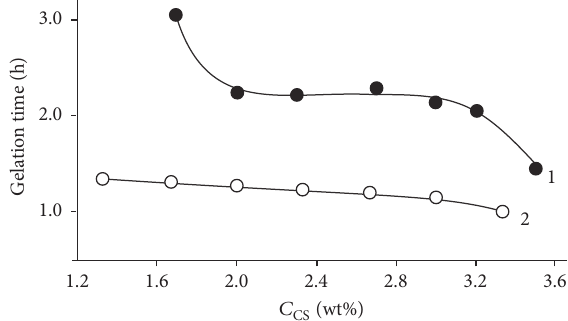
Figure 3: Dependence of the gelation time on 𝐶 SC for the system CS-GA + Si(OGly) 4 ⋅ 2GlyOH at 𝐶 Si = 1.21 (1) and 1.62% (2), aX ∼ 4.47 ± 0.03, 37 ∘ C.